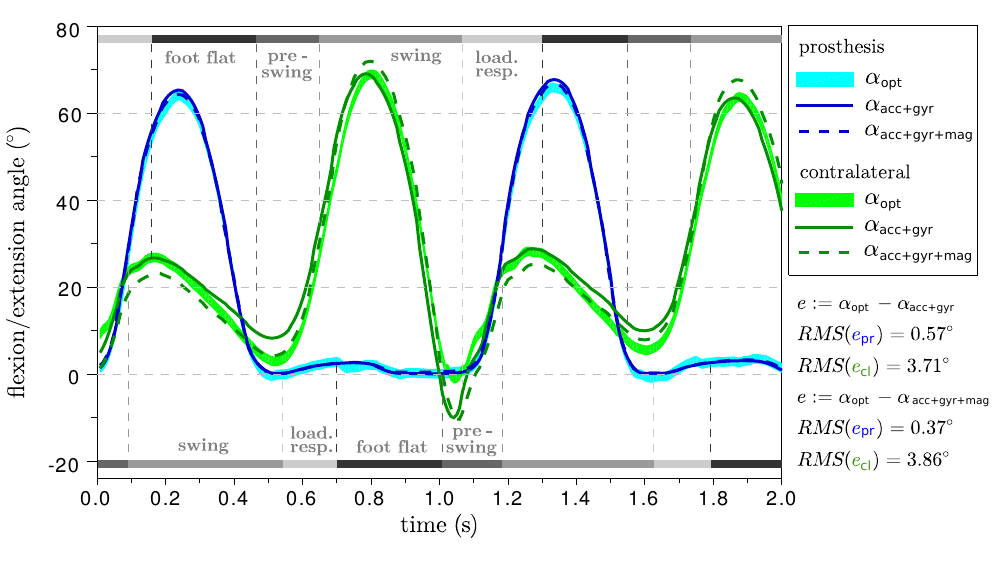
Figure 8. Comparison of the two IMU-based knee flexion/extension angle measurements ( t ) and α ( t ) ) with the result of an optical gait analysis system ( α ( t ) ). ( α acc+gyr+mag acc+gyr opt < 0 . 6 ◦ ). However, on the On the prosthesis side, there is no significant deviation ( e pr contralateral side, skin and muscle motion effects, which are strongest during push-off and heel-strike, lead to RMS errors e of almost 4 ◦ . cl